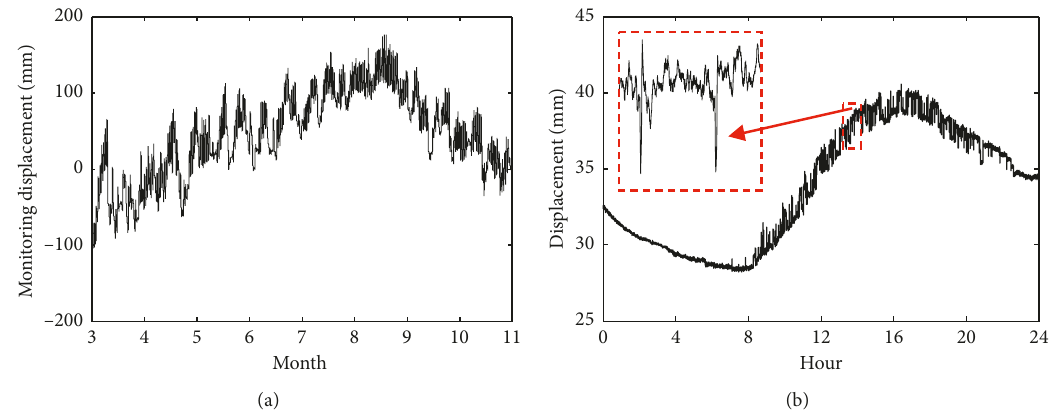
Figure 3: The monitored result of D